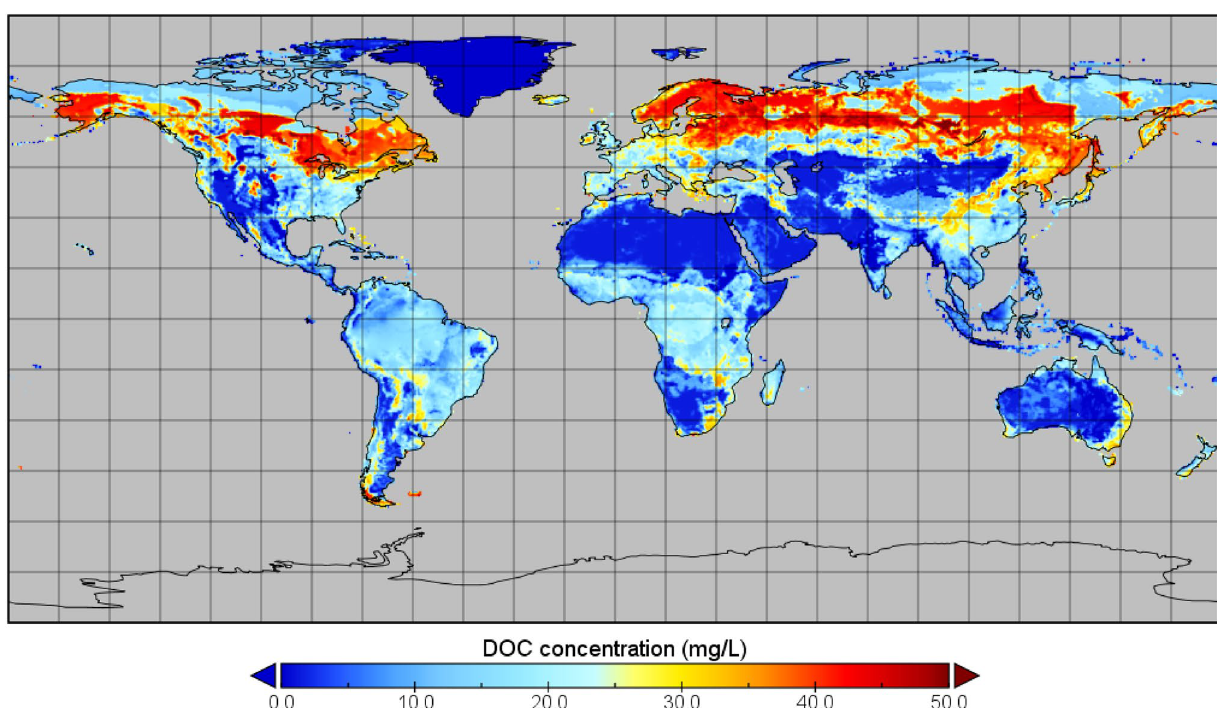
Fig. 8 Modelled global topsoil DOC concentrations in soil solutions (mg C L −1 ) for the year 2000 with a 30 min